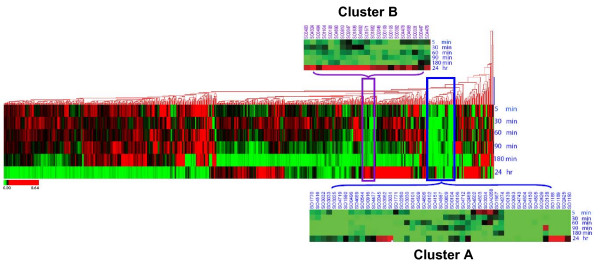
Complete linkage clustering analysis of genes with altered expression profiles in the Δso2426 mutant. The 841 genes (out of the 4,648 represented on the microarray) exhibiting at least a twofold statistically significant (p < 0.05) change in expression for at least one of the time points during Cr(VI) exposure were analyzed by pairwise complete-linkage clustering. Transcriptional profiles are shown at 5, 30, 60, 90, 180 min, and 24 h post chromate addition. Individual genes are represented by a single row, and each exposure time interval is represented by a single column. Red represents induction, while green represents repression. Two noteworthy clusters (A and B) are indicated, with their respective expression heat maps enlarged.